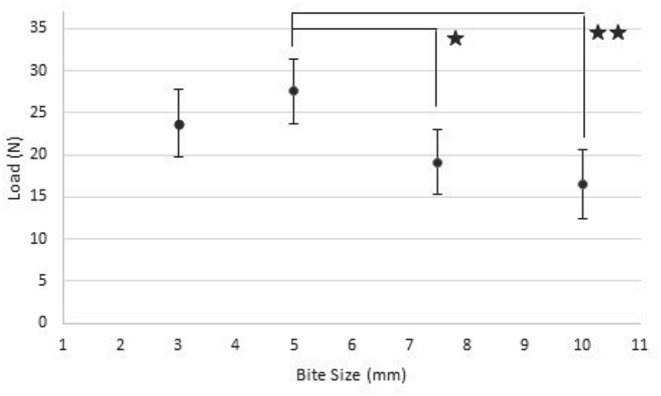
Expected load (black dot) with 95% CI (vertical bar) at failure or maximum displacement for each bite size and suture distance (x-axis: Bite Size) (n = 125). One star indicates groups are significantly different with P < 0.02, two stars indicates a significant difference of P < 0.001.